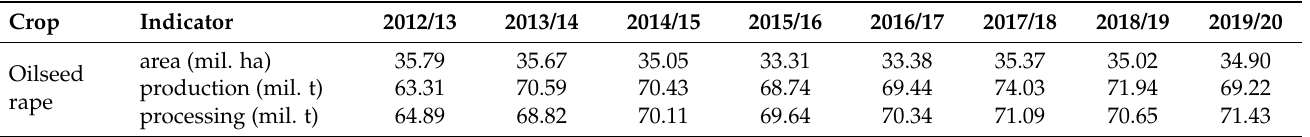
Table 2. World area, production and processing of rapeseed.